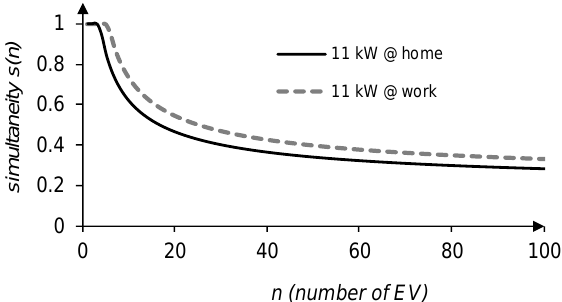
Fig. 4. Simultaneity functions for charging infrastructure with a power of 11kW.